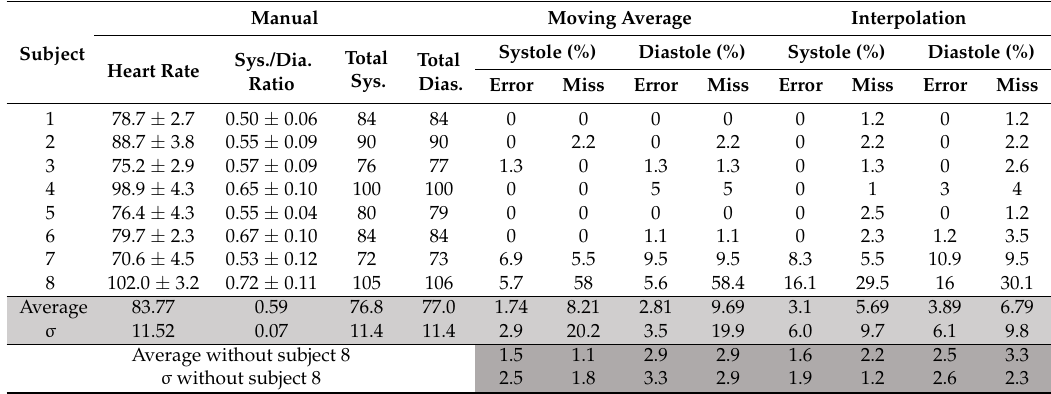
Table 8. The error and missing rates of moving average threshold and interpolation algorithms with total Z-axis acceleration (Equation (4)) on eight